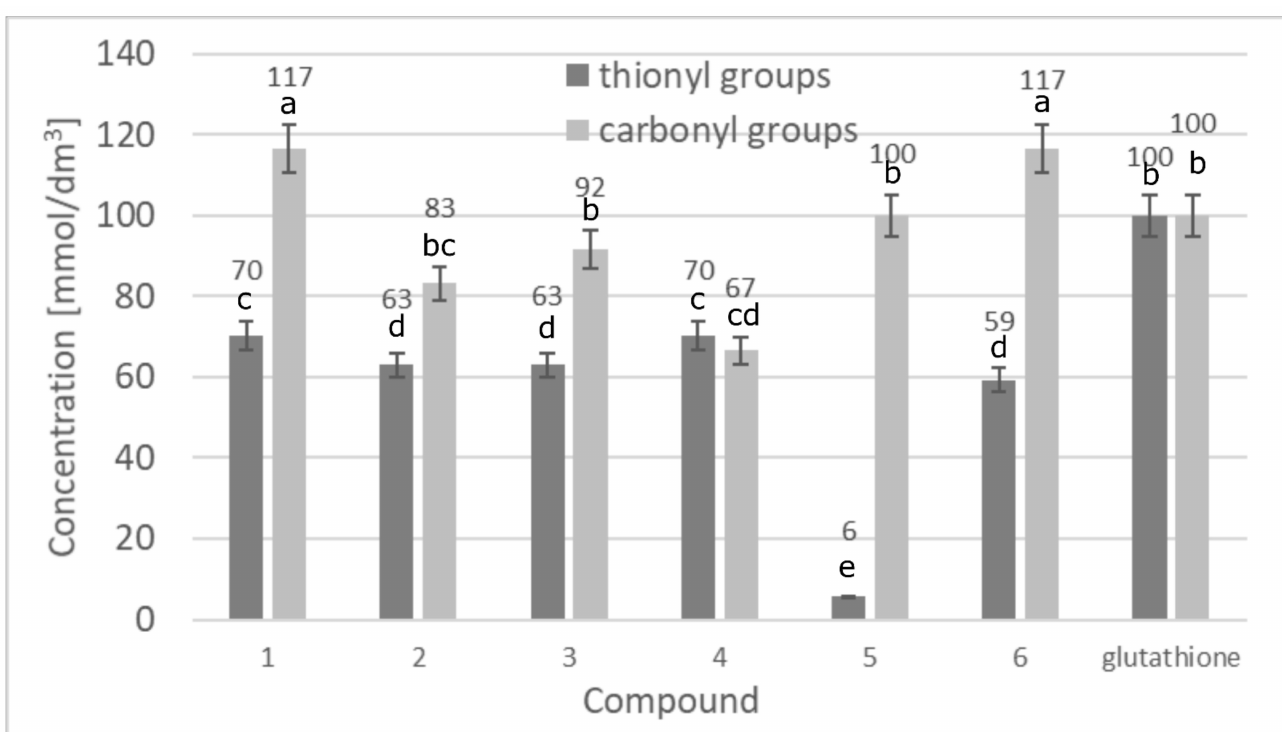
Figure 4. Protective activity for protein structures presented as the concentrations of thionyl and carbonyl groups, (1: lupeol, 2: lupeol acetate, 3: lupeol propionate, 4: lupeol isonicotinate, 5: lupeol succinate, 6: lupeol acetylsalicylate). Data presented as mean values ± SDstandard deviation ( n = 3). Different letters (a–e) indicate significant difference between mean values at p <